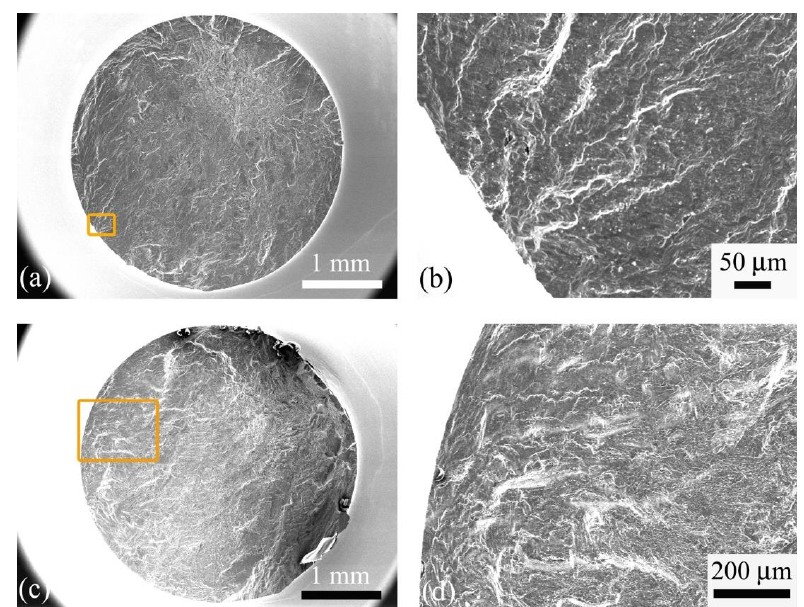
Figure 5. SEM images of fracture surface for notch specimens. ( a ) and ( b ) Multi-site crack initiation from the specimen surface at nominal stress amplitude σ a = 550 MPa and N f = 1.64 × 10 5 ; ( c ) and ( d ) Single-site crack initiation from the specimen surface at nominal stress amplitude σ a = 520 MPa and N f = 5.21 × 10 6 ; ( b ) and ( d ) Magnified view of the rectangular region in ( a ) and ( c ), respectively.